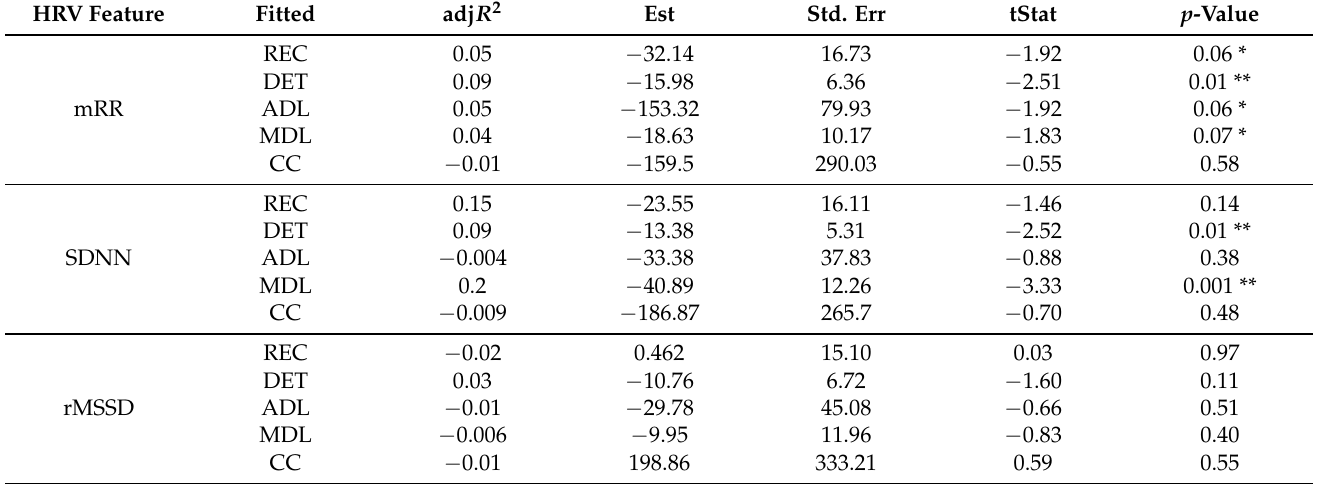
Table 2. Linear regression model of task performance and MdRQA indicators. Column headers, from left: HRV features; MdRQA indicators and CC analysis; adj. R 2 adjusted R-squared values; model estimate; standard error of the model; t statistics; p significant value.